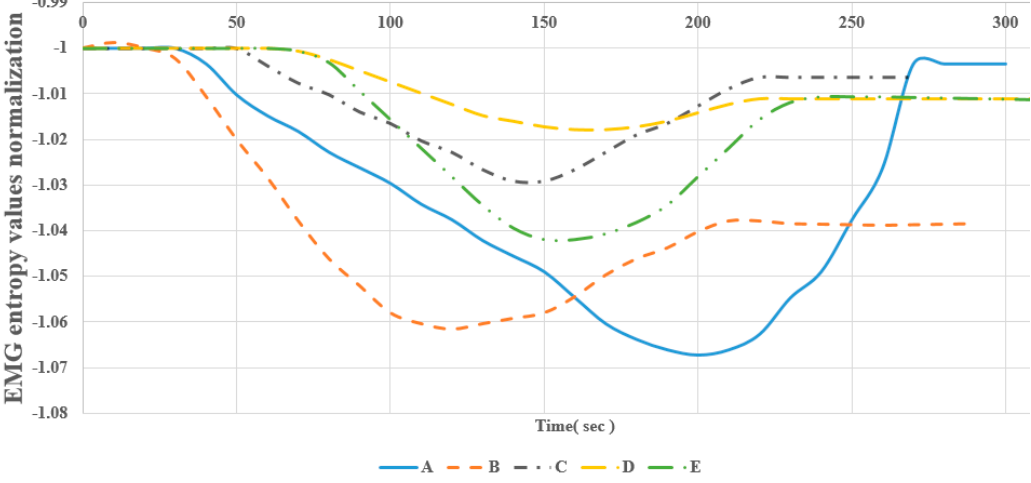
Figure 15. Comparison of entropy values of subjects under 4.5 kg load.